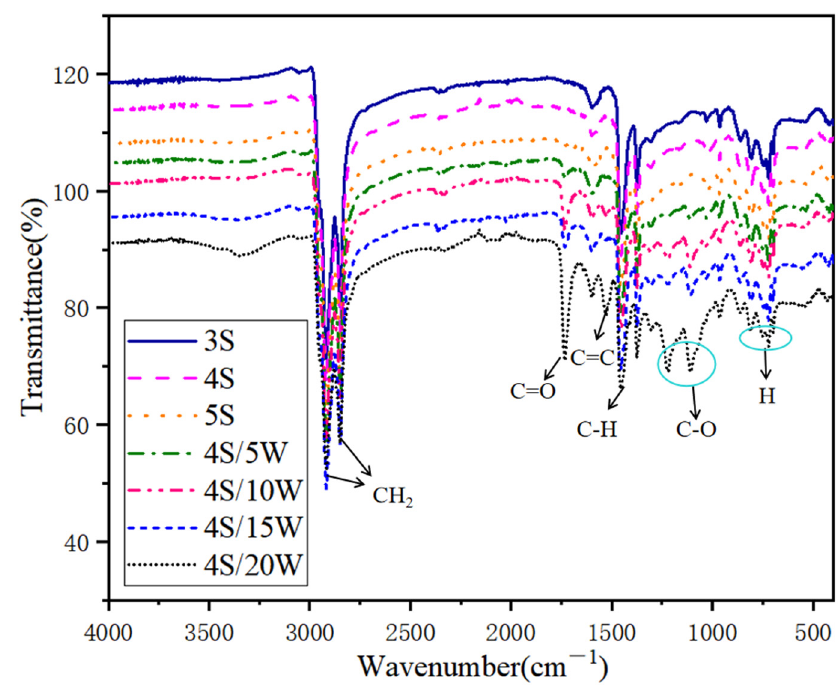
Figure 15. FTIR spectra of WPU/SBS composite modified asphalt.